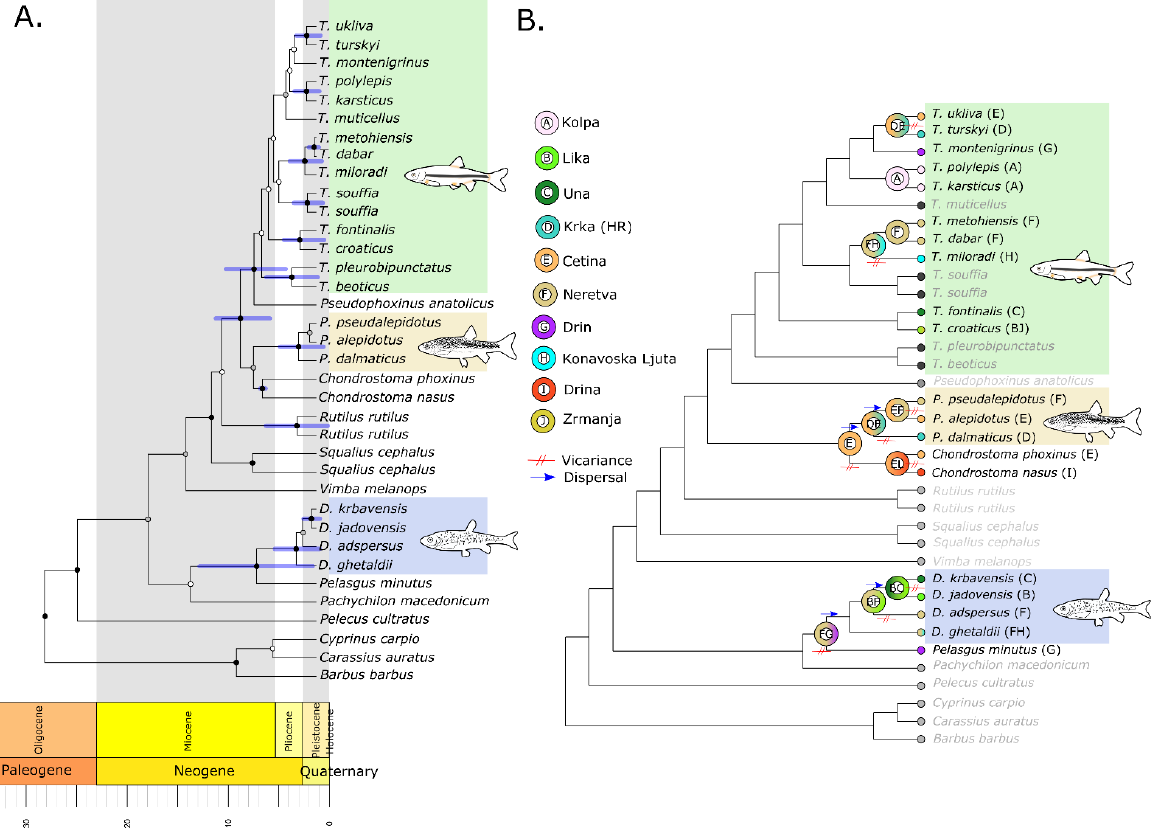
Figure 6. Divergence time estimates and reconstruction of ancestral areas (RASP) analyses of Del- minichthys , Phoxinellus and Telestes (together with sister genera and outgroups; for details see Table S3) based on cytochrome b fragment. ( A ) Divergence time estimates for Delminichthys (highlighted in blue), Phoxinellus (orange) and Telestes (green) with sister genera, calculated in BEAST [77]. Time of splitting is represented by horizontal bars corresponding to a 95% HPD interval. Posterior prob- abilities (pp) = ≥0.95 are indicated as black dots, pp = <0.95 and ≥0.75 are grey and pp = <0.75 are white. The scale represents millions of years. ( B ) Results from reconstruction of ancestral areas based on 10 biogeographic areas (see legend). The analysis was performed with S-DIVA [62] and imple- mented in RASP [85] based on the phylogenetic trees calculated in ( A ). Pie charts at nodes represent the most likely ancestral distributions and letters denote the regions encoded by the respective color (legend next to tree). Letters following tip labels indicate the recent distribution of each tip. Only ancestral areas with a probability of >0.5 are shown. Vicariance or dispersal events, or both, are given next to the pie chart. Only the topology is shown.